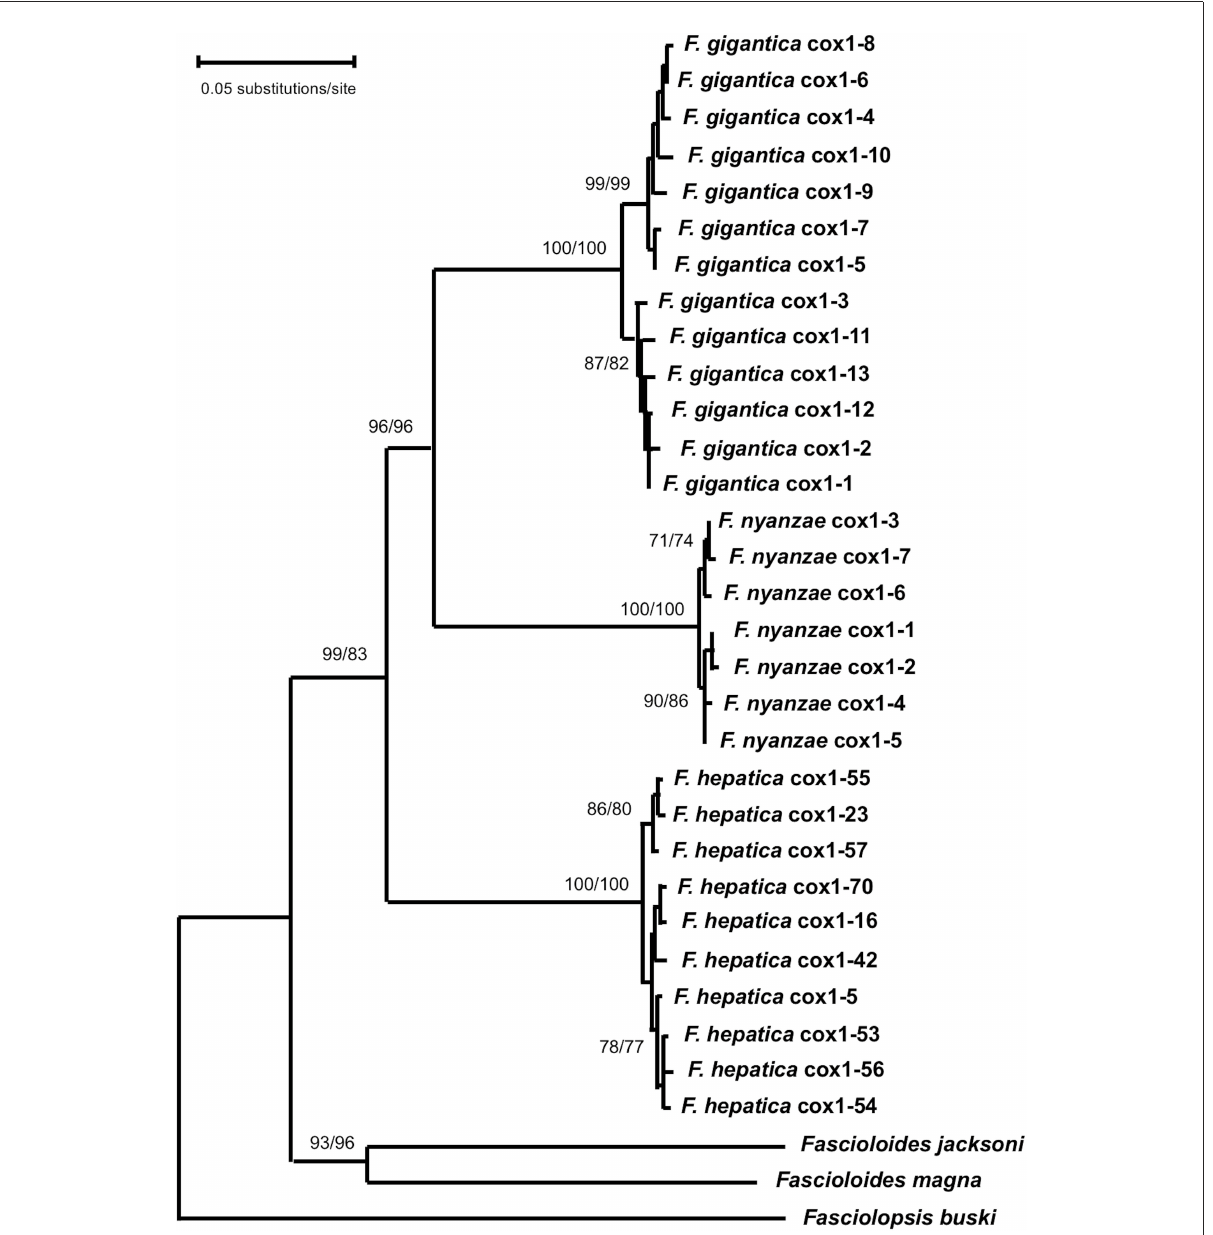
FIGURE4 Phylogenetic tree of species of Fasciola and Fascioloides based on maximum-likelihood (ML) estimates and reconstructed on mtDNA cox 1 sequences (LnL = − 5,733.3311). The tree is drawn to scale, with branch lengths measured in the number of substitutions per site. The tree was rooted using the sequence of Fasciolopsis buski (MF287794) as outgroup. Supports for nodes a/b using MEGA X: a, bootstrap (1,000 replicates) with ML parameters (T92 + G); b, bootstrap (1,000 replicates) with NJ and Tamura 3-p